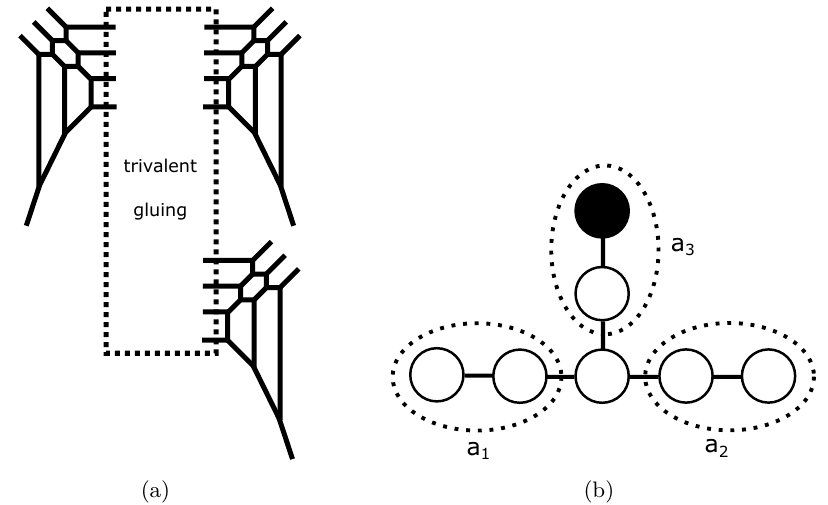
Figure 12. (a): The web diagram for the theory (2.51), which is ( E 6 , E 6 ) on S 1 . (b): The affine E 6 Dynkin diagram with the affine node given in black. a i next to a dotted circle implies that one node in the dotted circle is Higgsed when a i = 2 and two nodes in the dotted circle are Higgsed when a i = 3